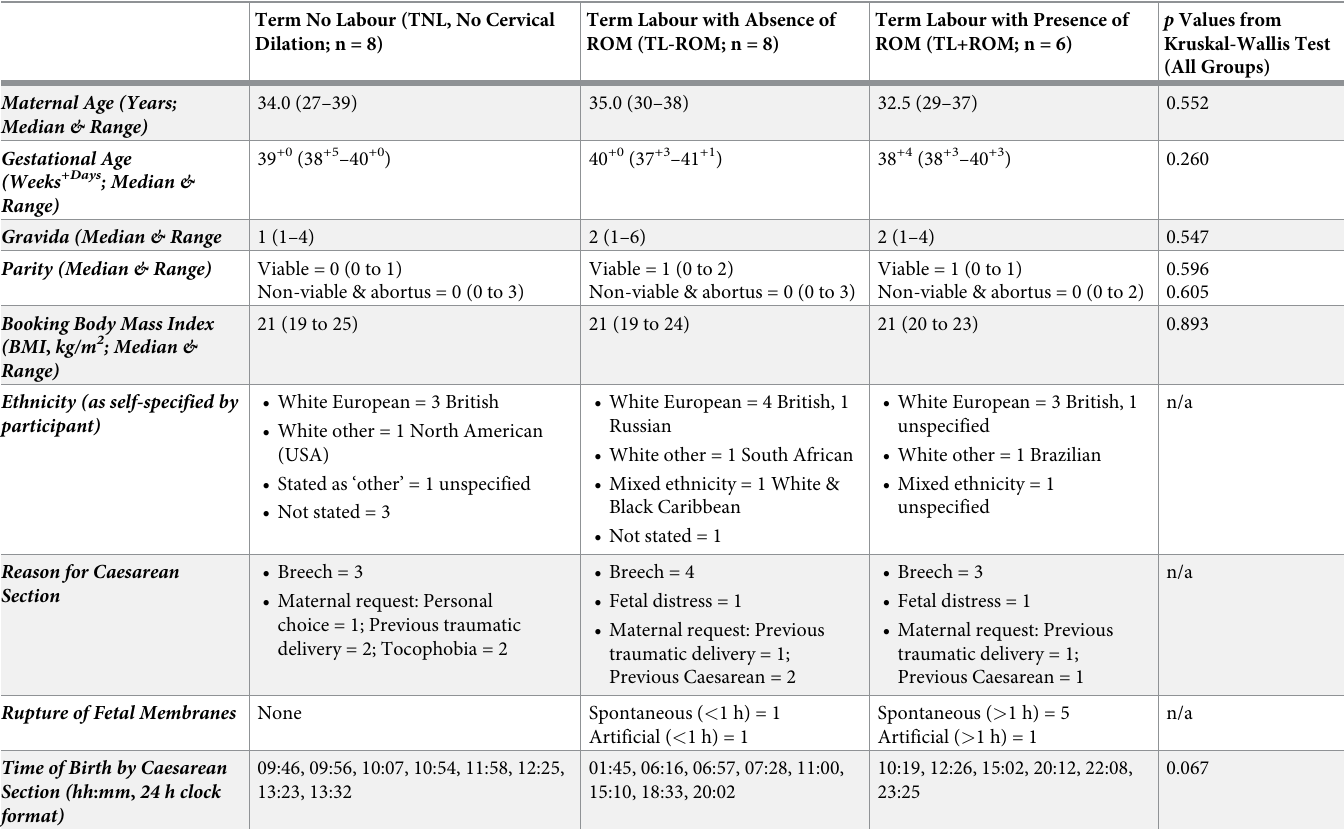
Table 3. Patient demographics for myometrium & placenta biopsies of the RNA-seq cohort—Grouped by status of fetal membrane rupture (ROM). Term No Labour (TNL, No Cervical Dilation; n = 8)